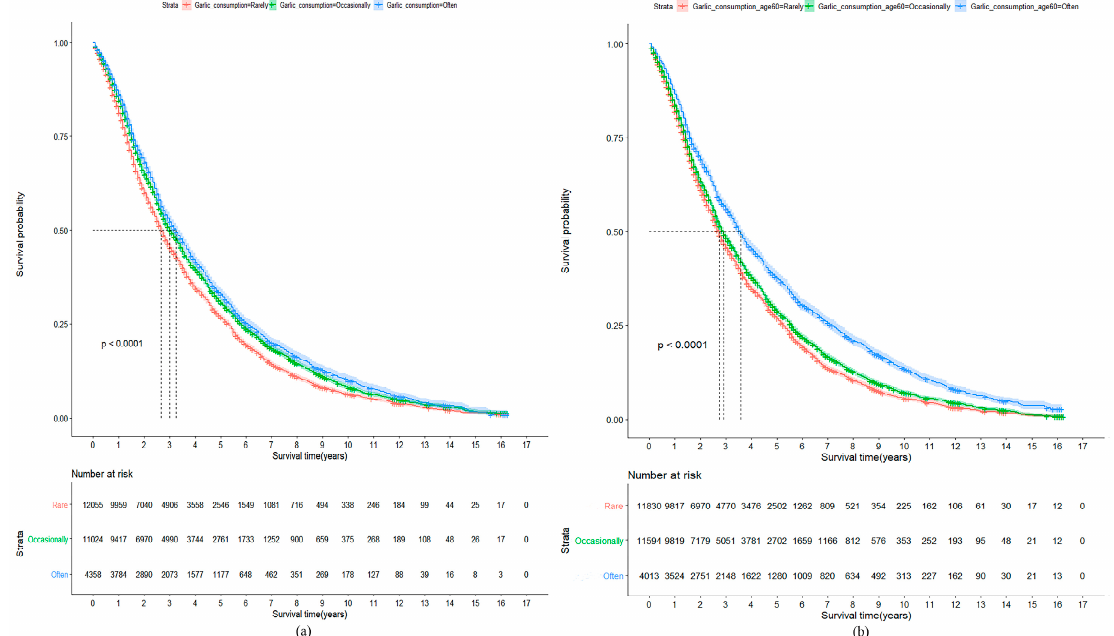
Figure 1. ( a ) Kaplan–Meier plot showing mortality according to garlic consumption at baseline. Participants who often or occasionally consumed garlic at baseline survived longer than those who rarely consumed it (median survival time was 3.2, 3.0, and 2.7 years, respectively; p < 0.001). ( b ) Kaplan–Meier plot showing mortality according to garlic consumption at age 60. Participants who often consumed garlic at age 60 survived approximately one year longer than those who occasionally or rarely consumed it (median survival time was 3.7, 2.9, and 2.8 years, respectively; p < 0.001).